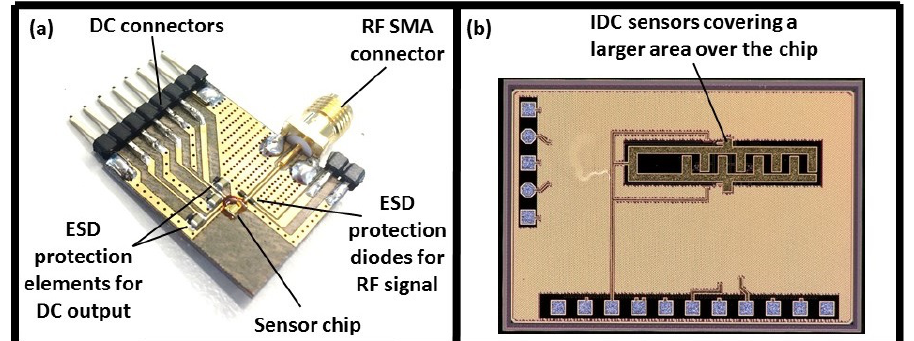
Figure 2. ( a ) ESD-protection elements mounted on the PCB, ( b ) modified chip with a larger sensing area